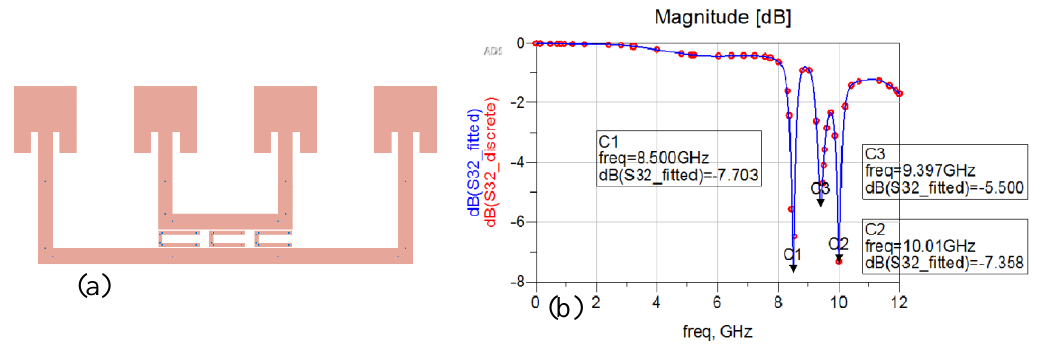
Figure 14. ( a ) Three-bit chipless linear Van Atta array composed of four elements with three C resonators. ( b ) Simulated backscattered response in the X band (8GHz–12GHz).